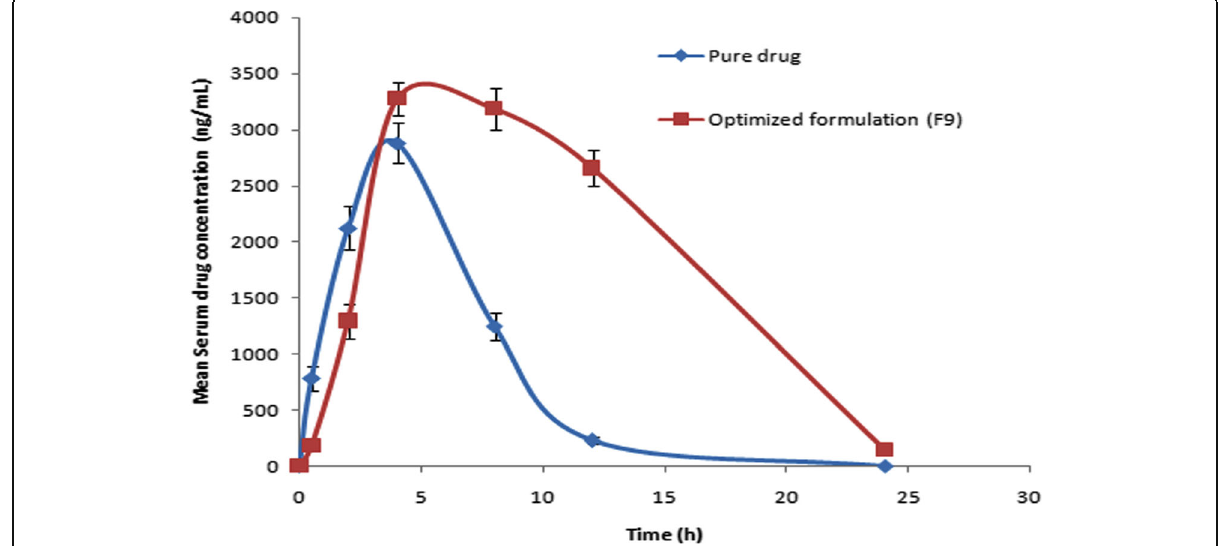
Fig. 3 Plot depicting the mean serum concentration vs time of optimized FMM and Pure drug